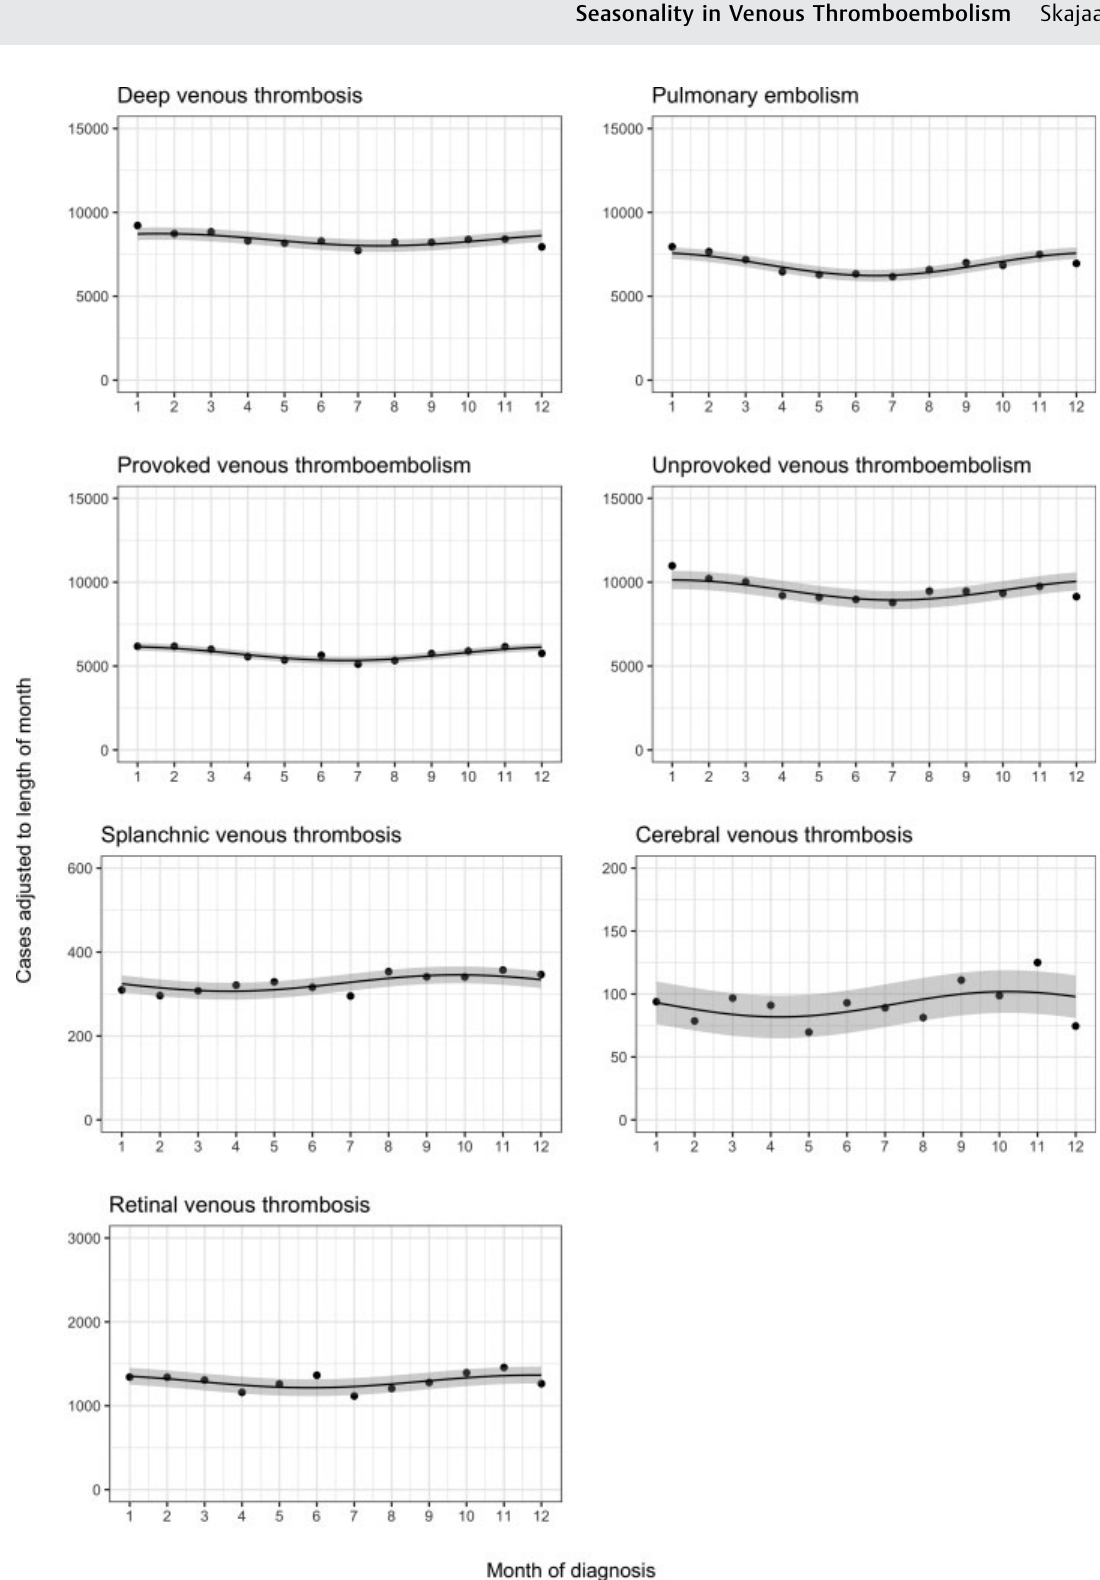
Fig. 1 Summarized cases within each calendar month during 1977 – 2016 (occurrence of deep vein thrombosis, pulmonary embolism, provoked venous thromboembolism, unprovoked venous thromboembolism, splanchnic vein thrombosis) and 1994 – 2016 (occurrence of cerebral vein thrombosis and retinal vein thrombosis), adjusted for the length of month with a fi tted sine curve and 95% con fi dence